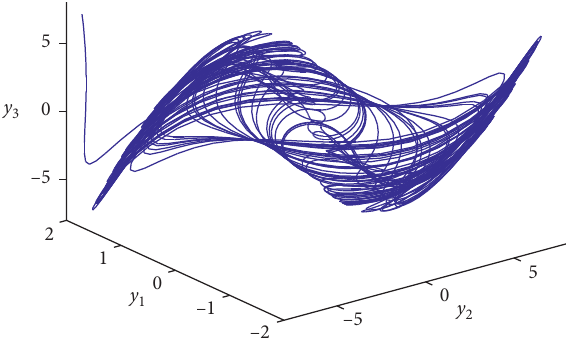
Figure 1: The chaos attractor of system (47) with x